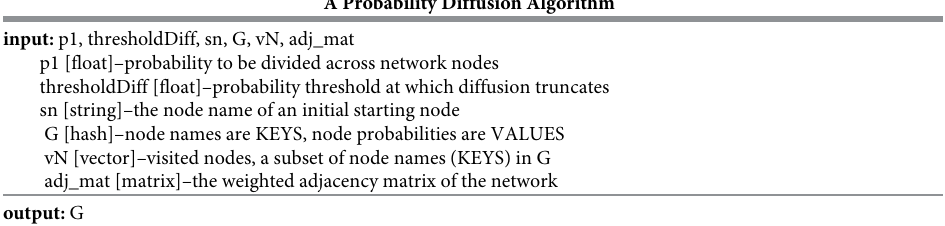
Table 2. A probability diffusion algorithm. A probability score is propagated through a network structure starting from an initial starting node (sn). In lines 4–13, probability is split preferentially between unvisited network neighbors of the starting node by edge weight and propagated recursively to secondary neighbors until the probability being dif- fused is less than a defined parameter, thresholdDiff (default set to 0.01). If the starting node, sn, has no unvisited neighbors, p1 is distributed uniformly amongst all unvisited nodes, regardless of proximity to sn (lines 15–16). A Probability Diffusion